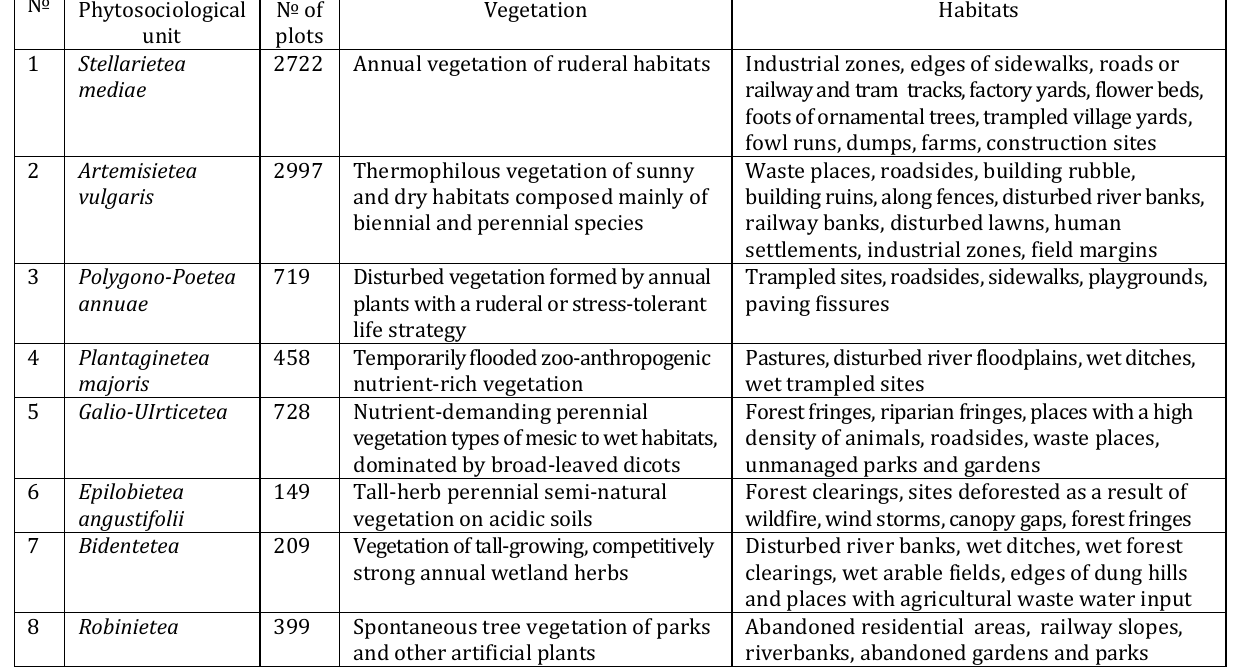
Table 1. Overview of ruderal vegetation types with the characterization of their